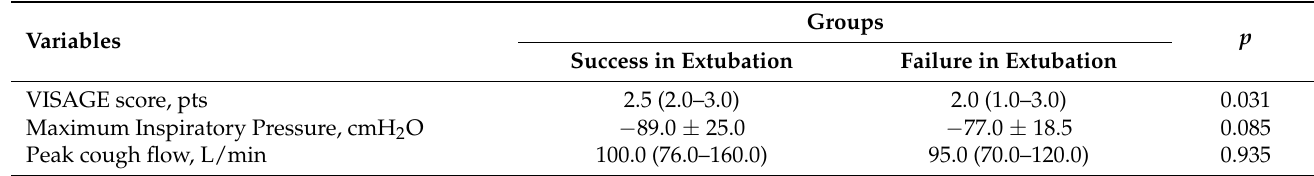
Table 2. Performance of the VISAGE score, MIP, and peak cough flow in each